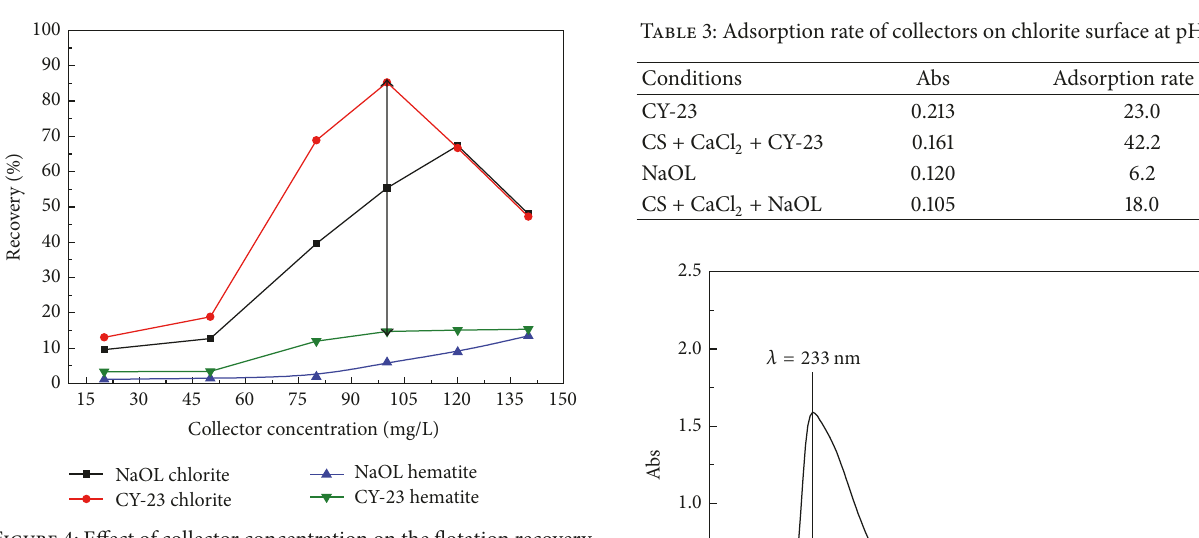
Figure 4: Effect of collector concentration on the flotation recovery of chlorite and hematite { pH = 10, 𝑐 (CaCl 2 ) = 100mg/L and 𝑐 (CS) = 20 mg/L } .